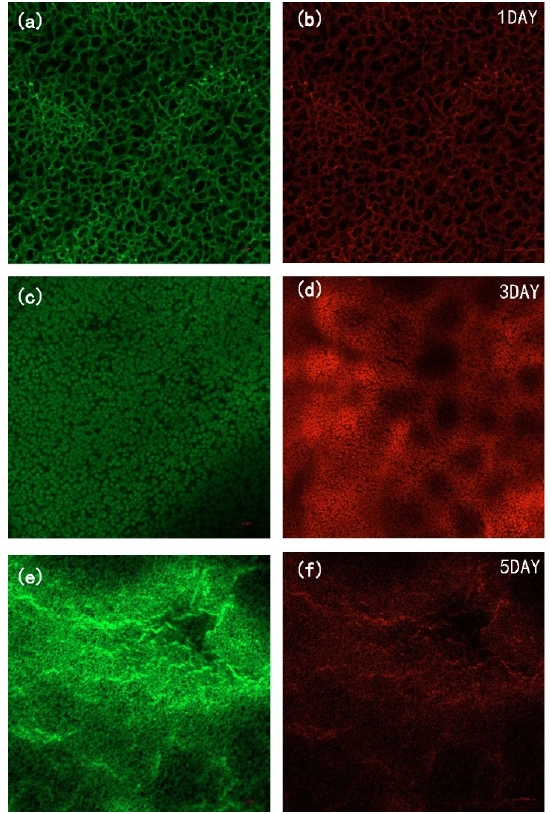
Figure 10. CLSM images of PVDF membrane during five days of bacterial culture cycle. ( a , c , e ) Live bacteria on PVDF membrane; ( b , d , f ) dead bacteria on PVDF membrane.